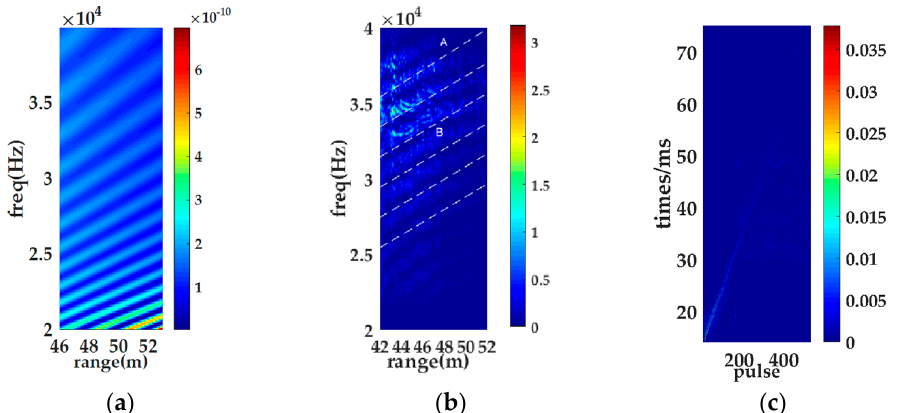
Figure 7. Comparison between the experiment result and the simulation result at 20 − 40 kHz: ( a ) simulation result; ( b ) experiment result; ( c ) the motion trajectory.